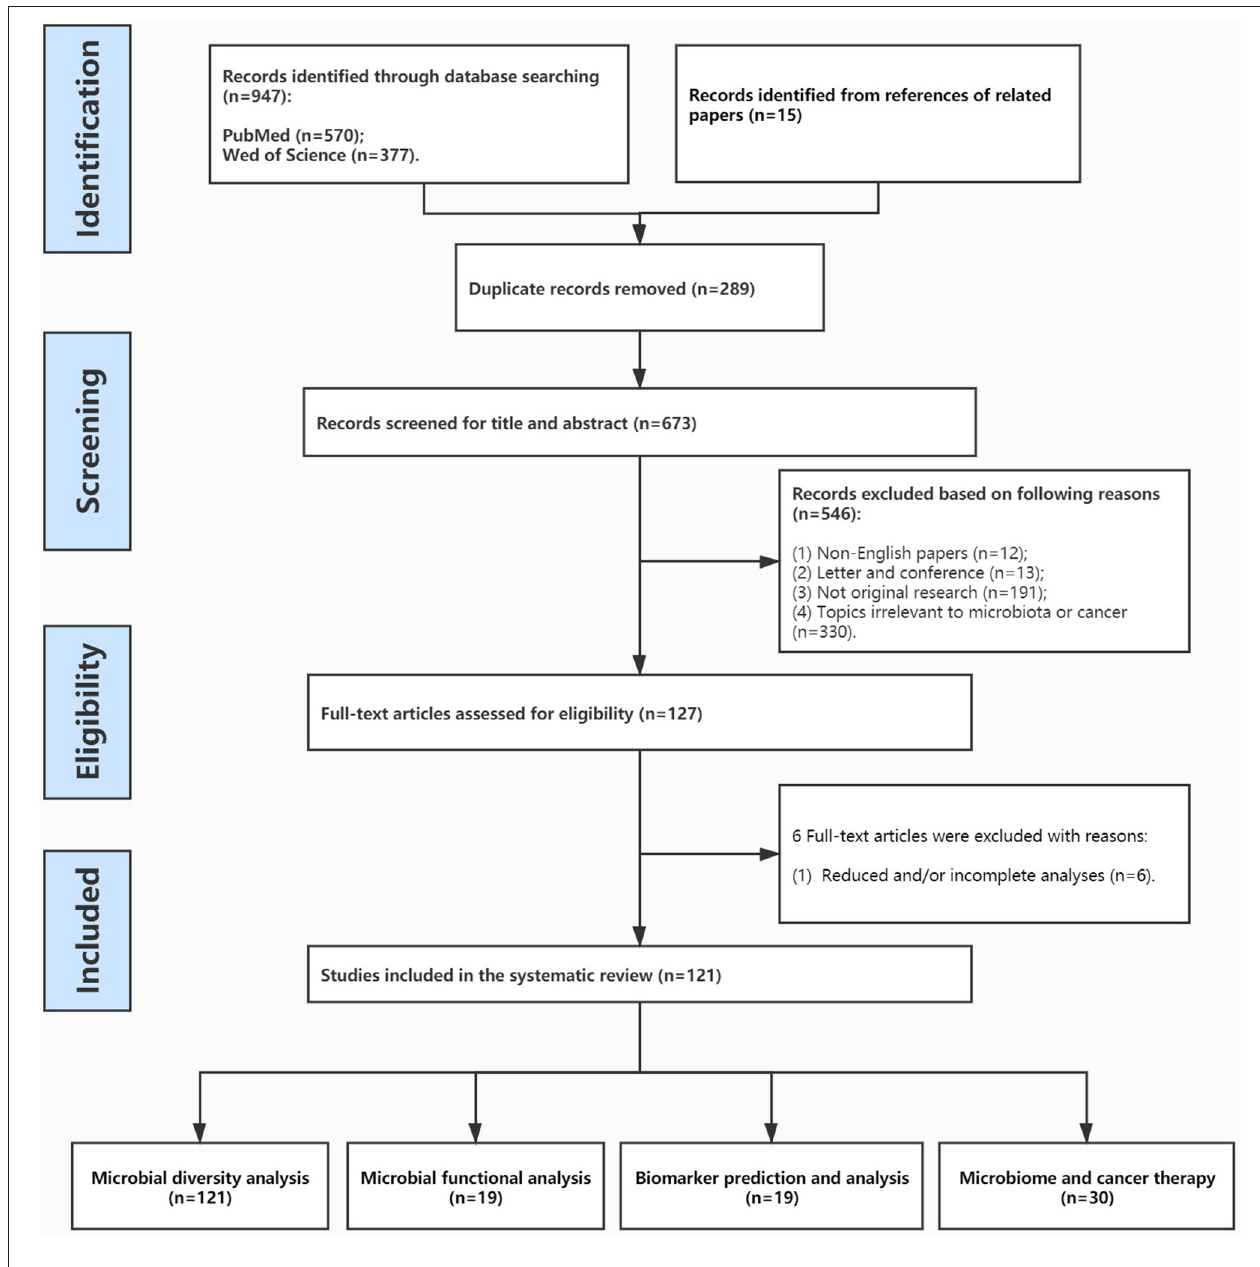
FIGURE 1 | PRISMA graph detailing the search